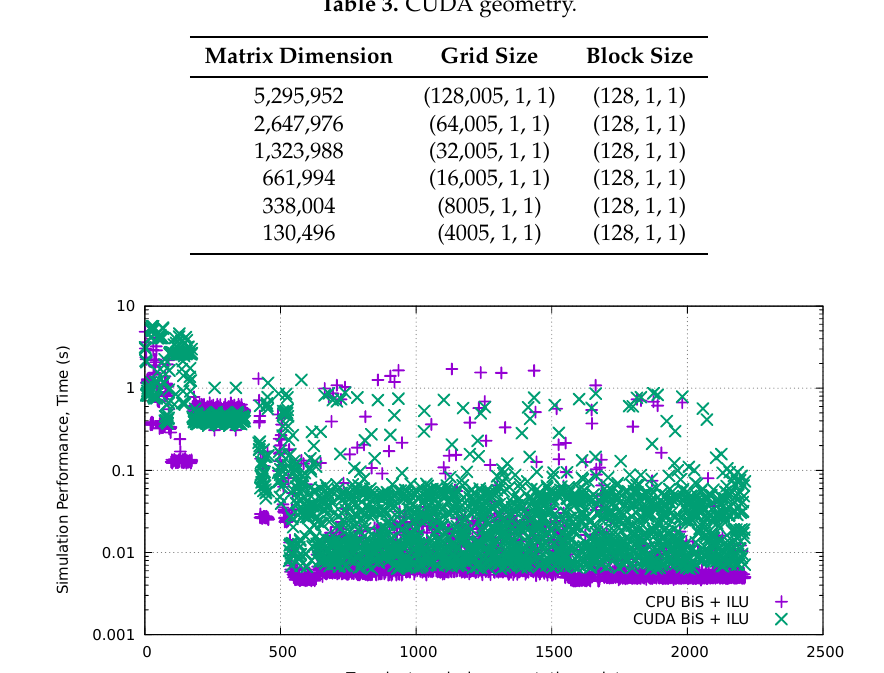
Table 3. CUDA geometry.